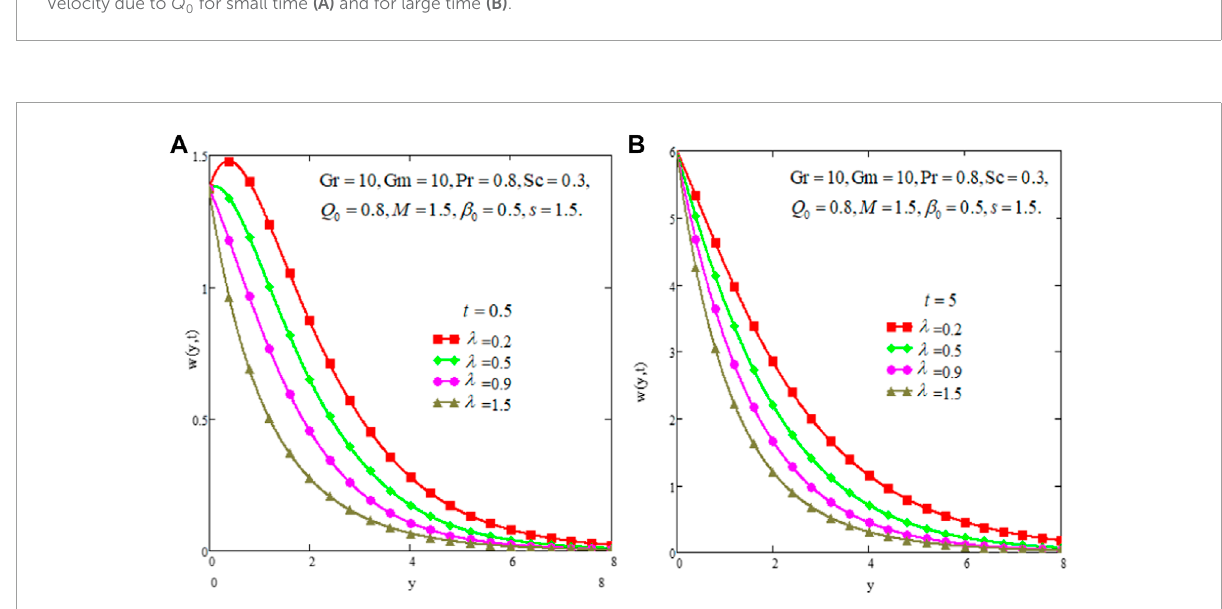
FIGURE 7 Velocity due to λ for small time (A) and for large time (B)